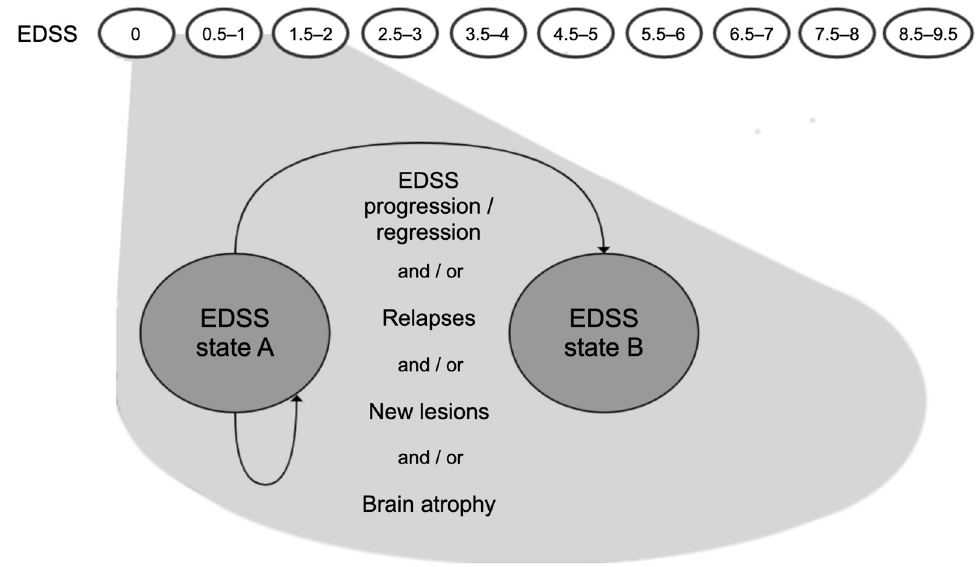
Figure 1. Schematic representation of the Markov model for disease progression; EDSS = Kurtzke Expanded Disability Status Scale; state A = EDSS state at the start of a model cycle; state B = EDSS state at the end of a model cycle. EDSS progression (B > A), regression (B < A) or stability (B = A) are possible. Clinical and subclinical disease activity may occur during each cycle.